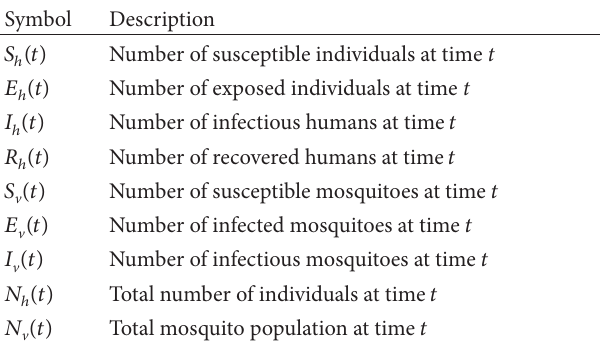
Table 1: State variables of the malaria model.